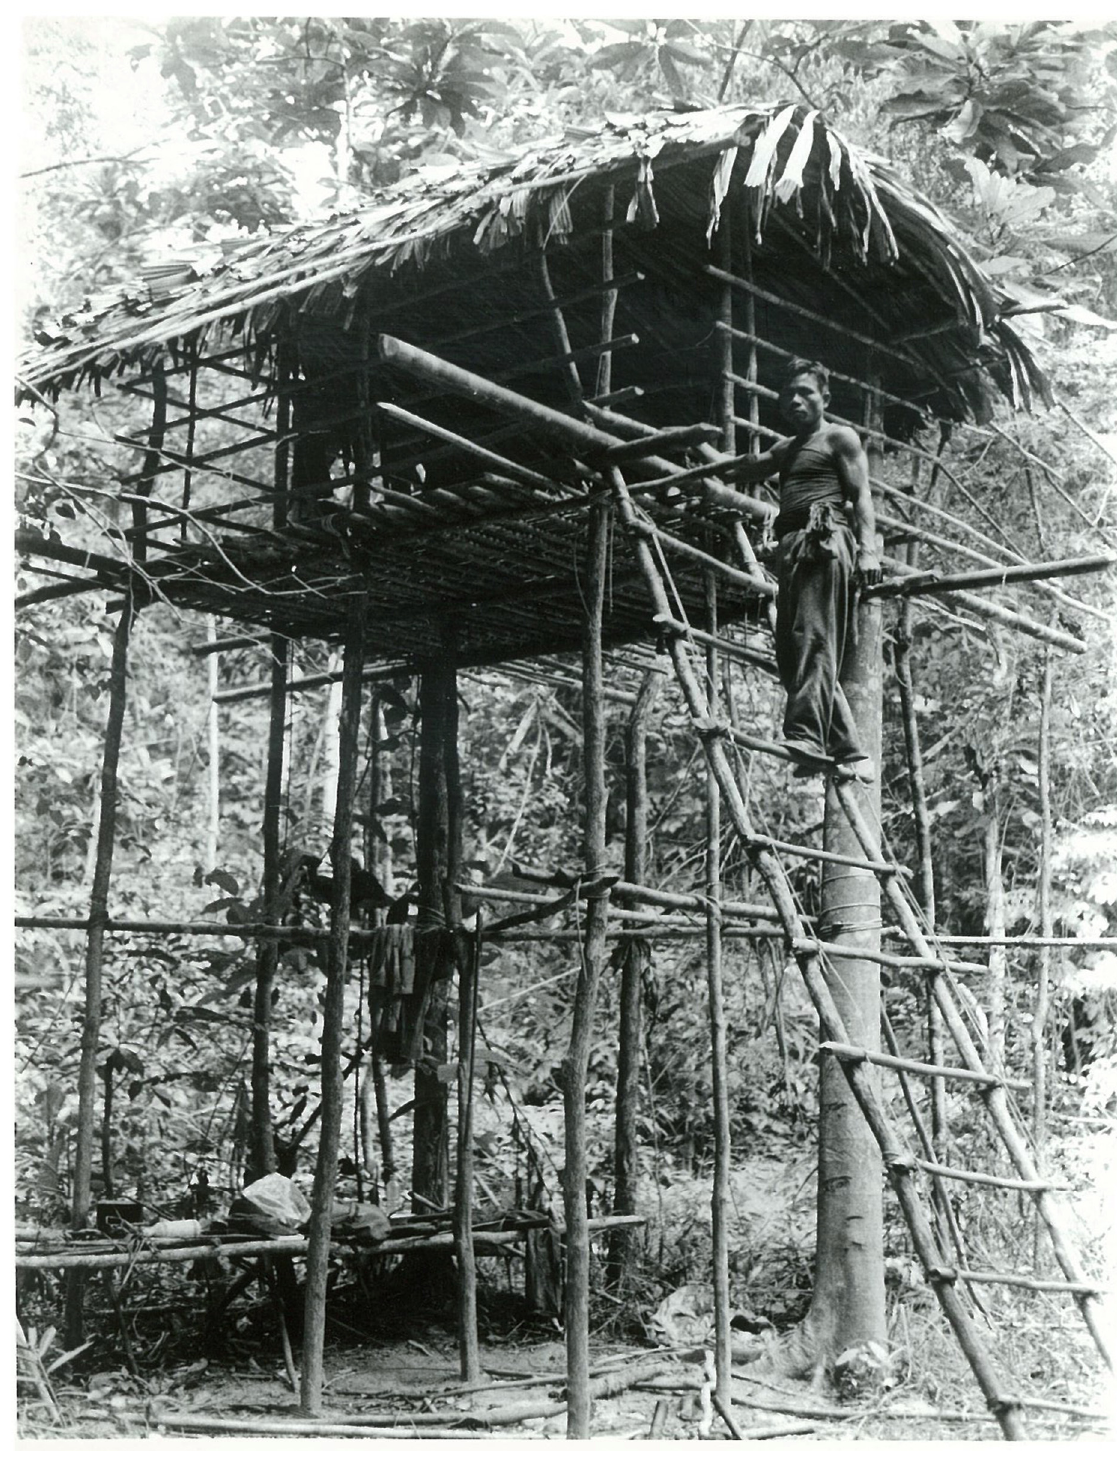
Figure 2. Hokin Sujin (a member of the Semelai swiddener community) with his shelter ( ponong ) used for weekly keruing ( Dipterocarpus ) oleo-resin tapping at Kemiyan, Tasek Bera, Pahang, 1980. (Photograph by Rosemary Gianno, Orang Asli Archive, Mason Library, Keene State College, reproduced with permission).